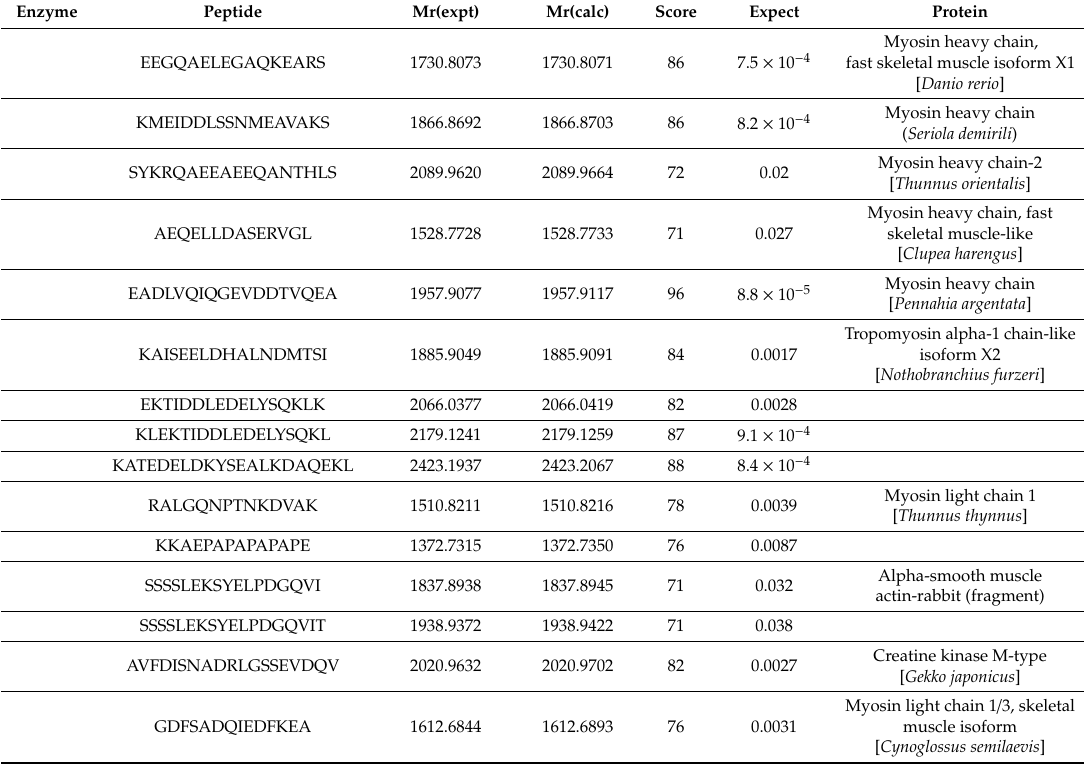
Table 1. Main peptide sequences identified in each of the enzyme’s hydrolysates; Mr(expt) and Mr(calc) are the experimental and calculated theoretical molecular weights; ‘Protein’ is the protein matching that